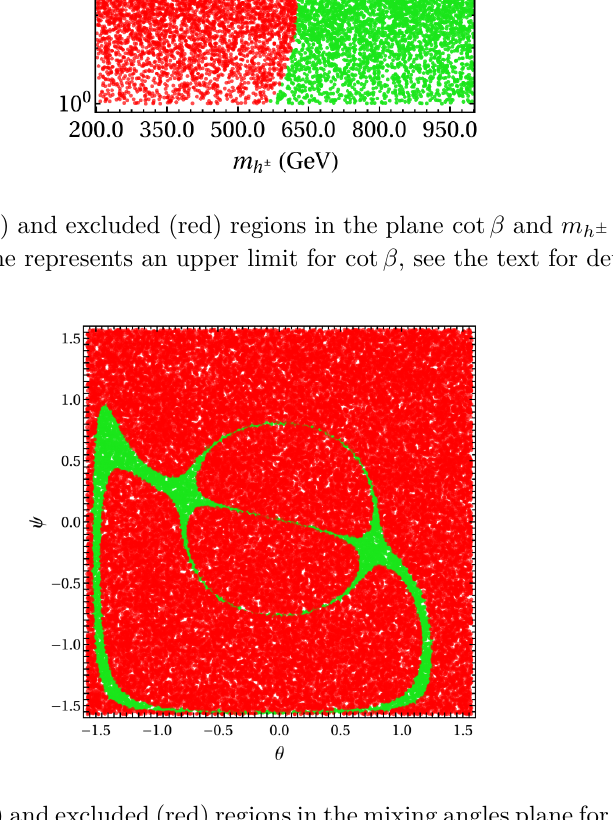
Figure 3 . Allowed (green) and excluded (red) regions in the mixing angles plane for m and tan β = 1